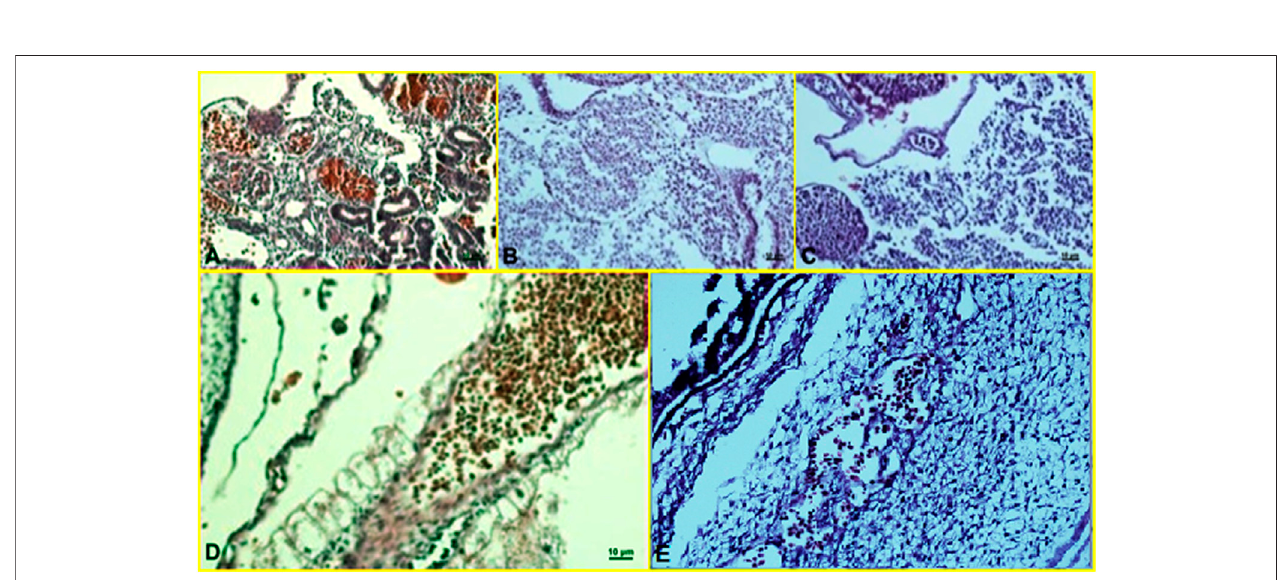
FIGURE 8 | Microscopy images of H&E staining of chick embryo (A) control group, (B) Amp B 1X, (C) Amp B 2X, (D) AmBisome 1X, (E) AmBisome 2X.